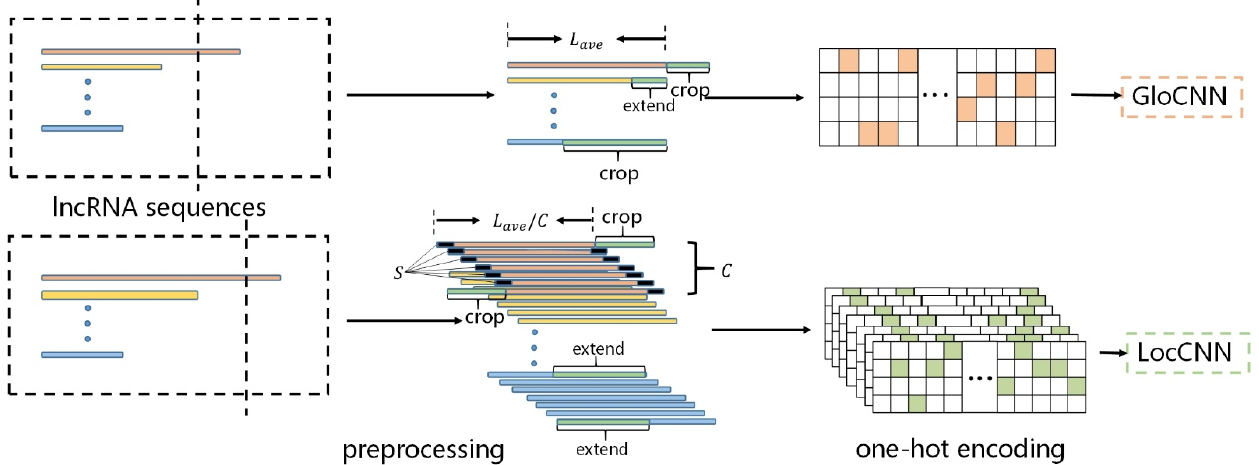
Figure 3. The flowchart of lncRNA sequence encoding. The two preprocessing methods are applied to transform the lncRNA sequences into fixed-length sequences. After that, the sequences are encoded by using one-hot encoding and fed into GloCNN and LocCNN. The protein sequences apply the same sequence encoding.